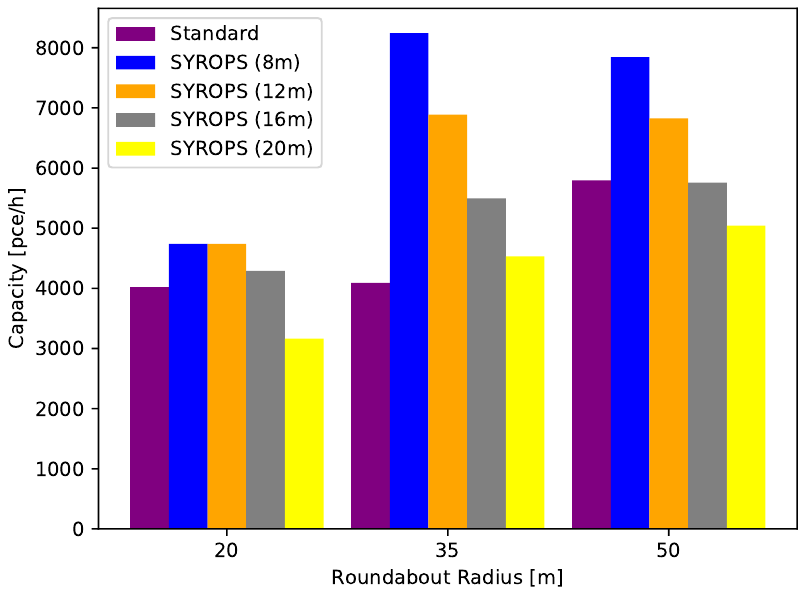
Figure 15. Roundabout capacity comparison versus size of the roundabout for standard roundabouts and SYROPS with and without